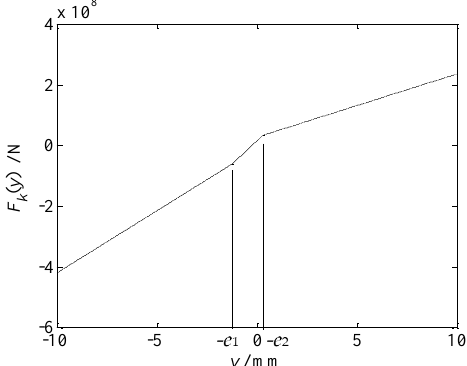
Figure 4. Piecewise nonlinear spring force of hot rolling mill rolls in the vertical direction.